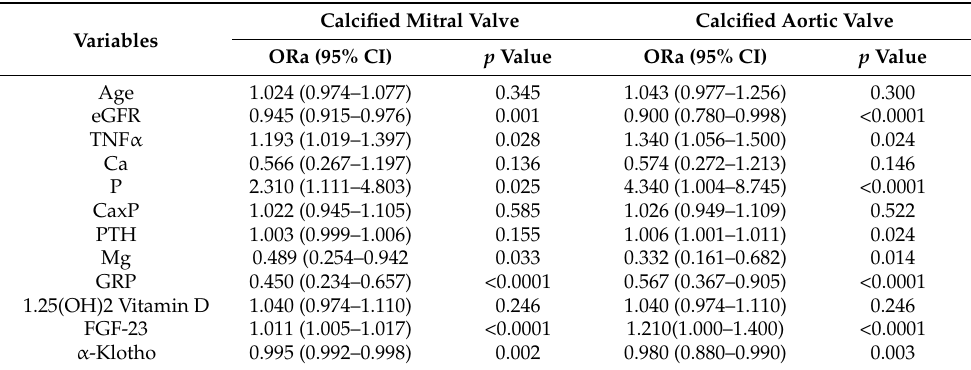
Table 4. Risk factors associated with mitral and aortic valves calcification.